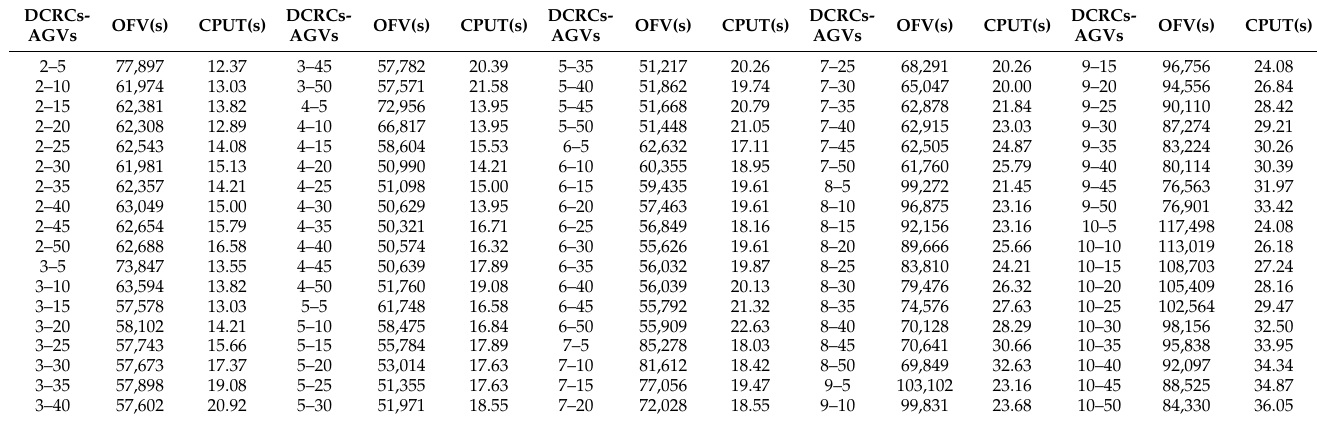
Table 4. Calculation example of 2 QCs.